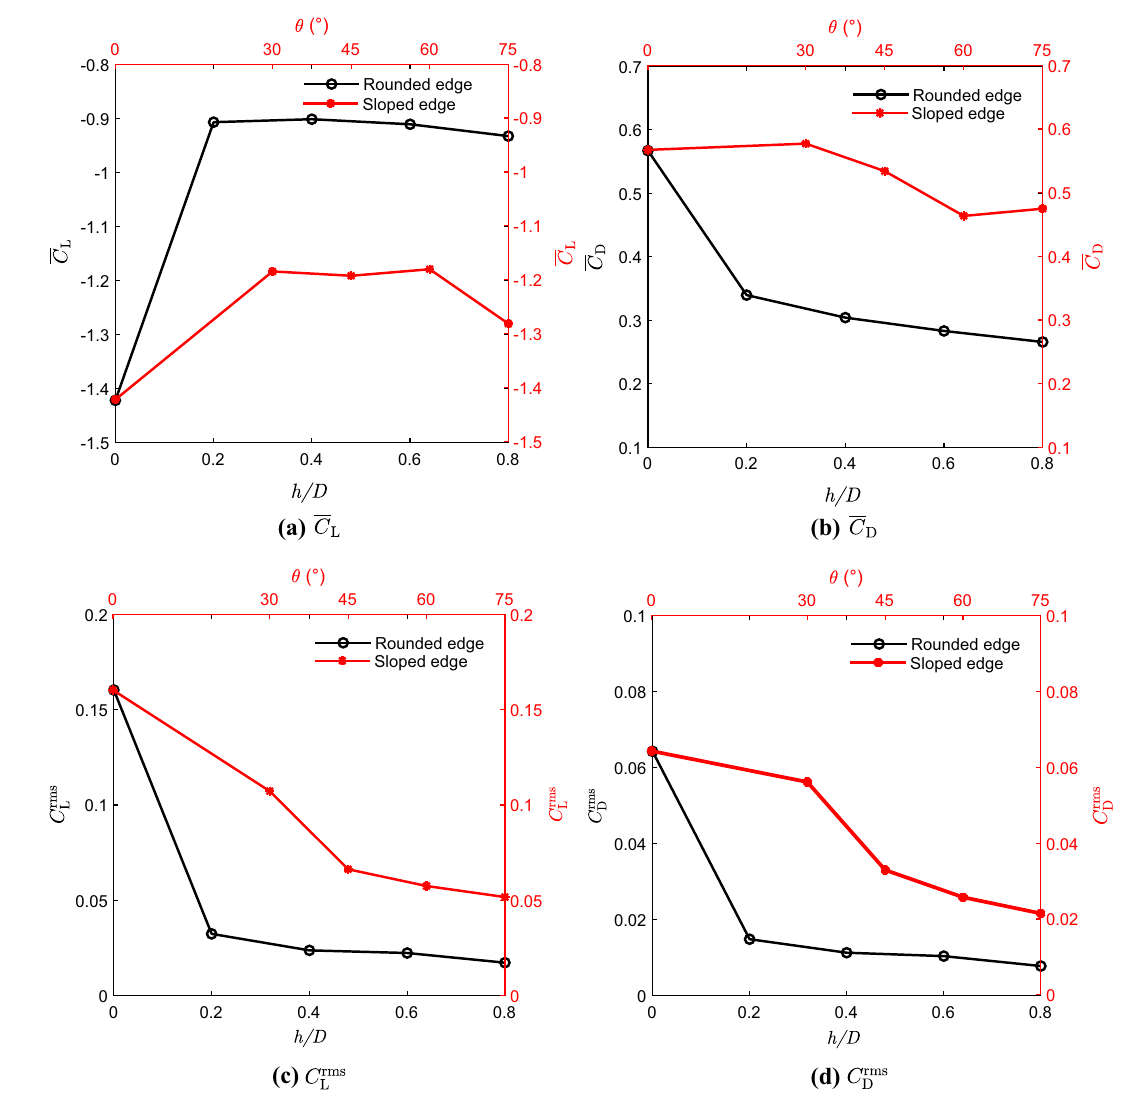
Fig. 6 Force coefficients for different cavity edge treatment